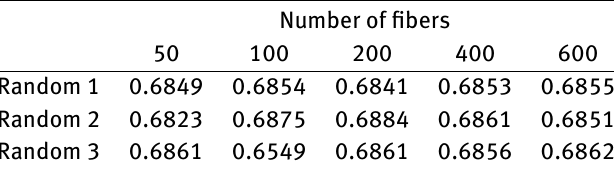
Table 3: Influence of random distributions of fibers on the effective thermal conductivity of composites with v f =